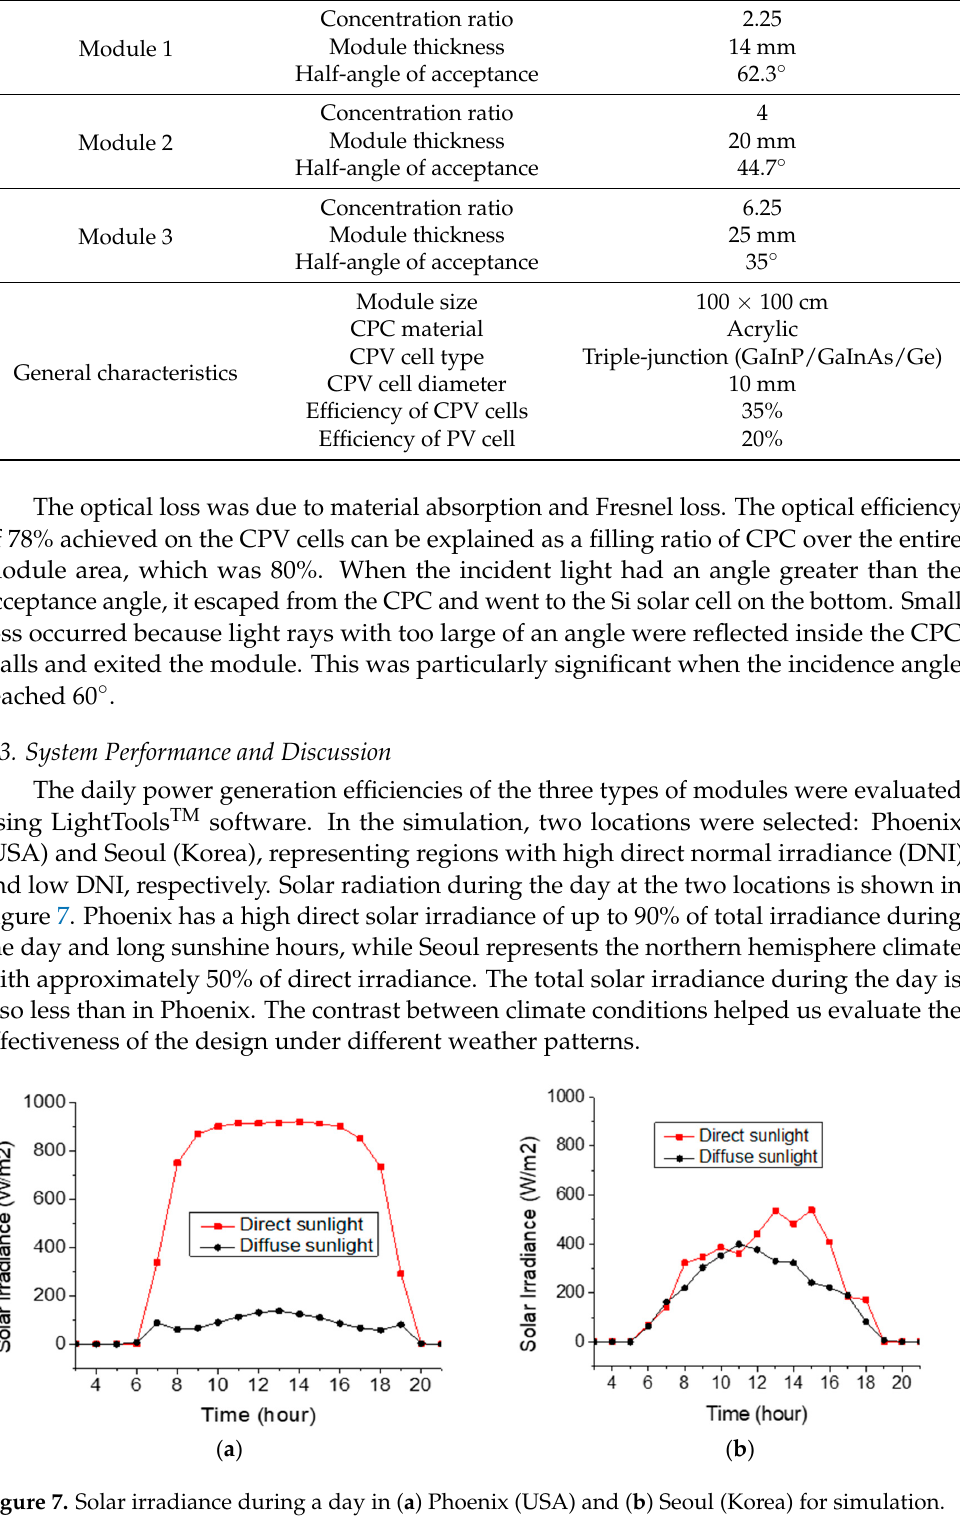
Table 1. Main parameters of the static CPV module.